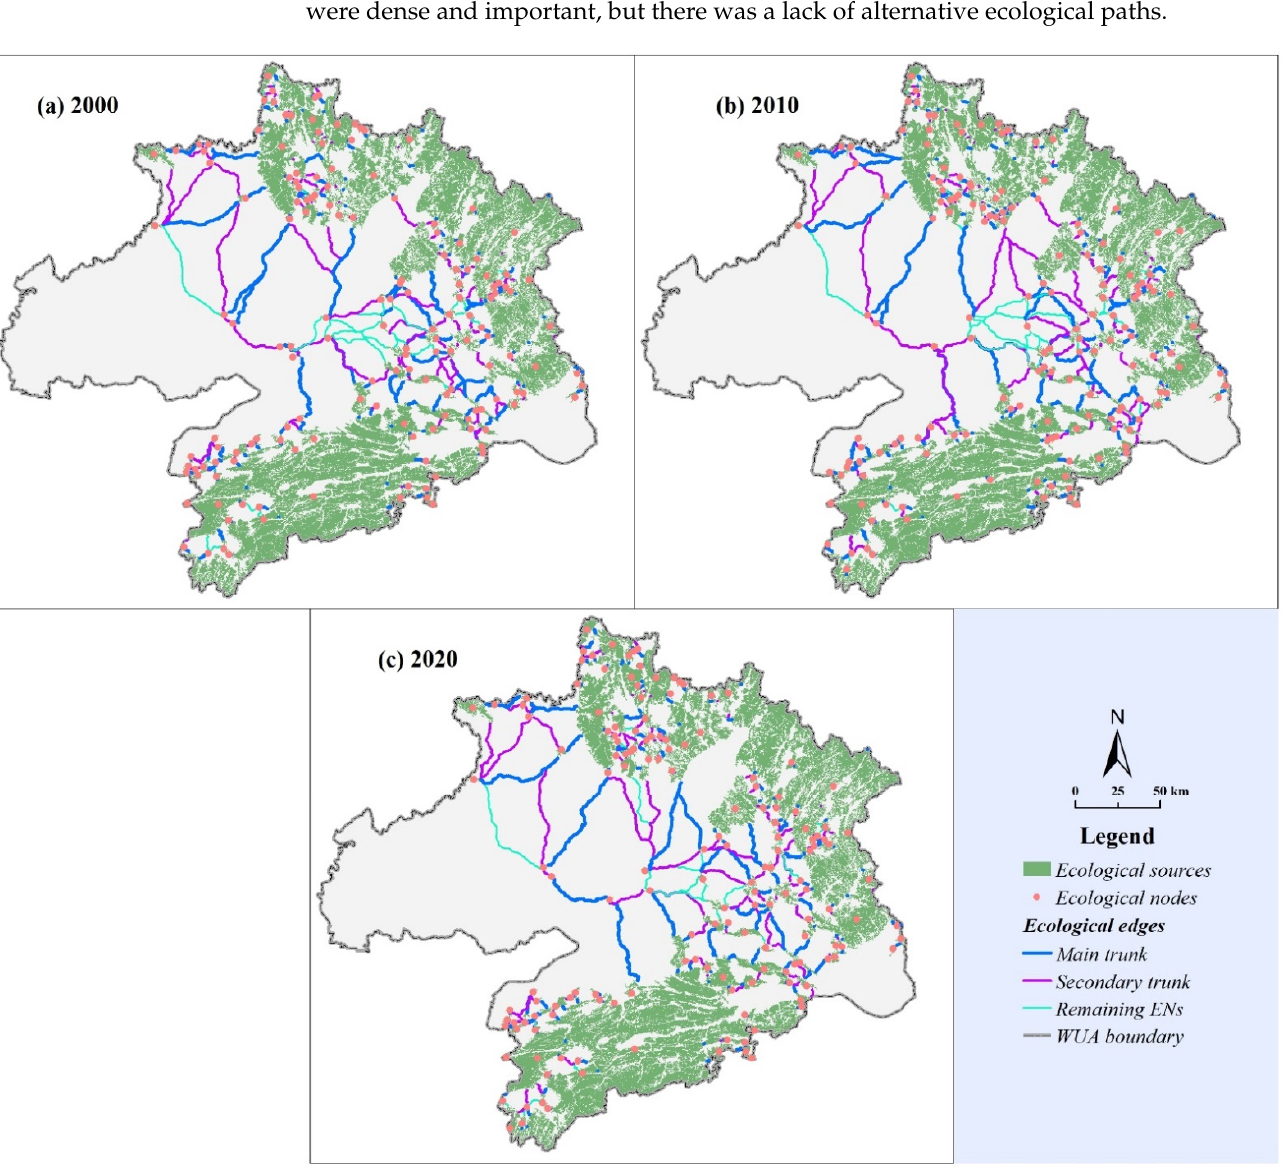
Figure 12. Spatial distribution of backbone structure for ENs in 2000, 2010, and 2020.